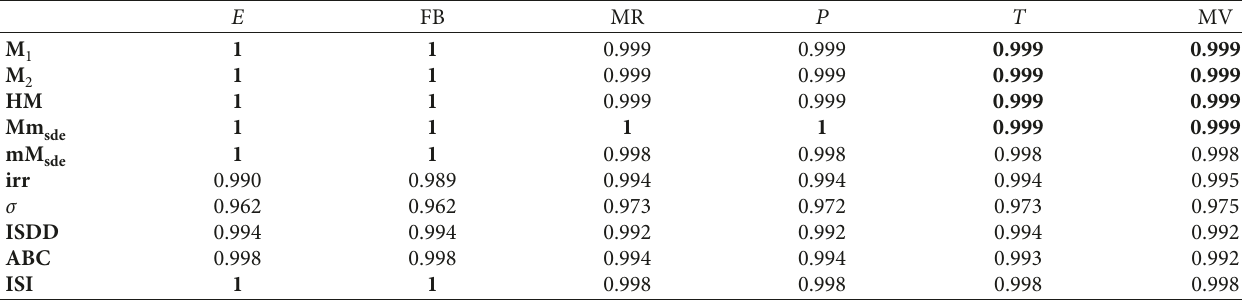
Table 6: The correlation coefficient ( R ) obtained by quadratic regression model between topological indices and physicochemical properties of various drugs used in treatment of